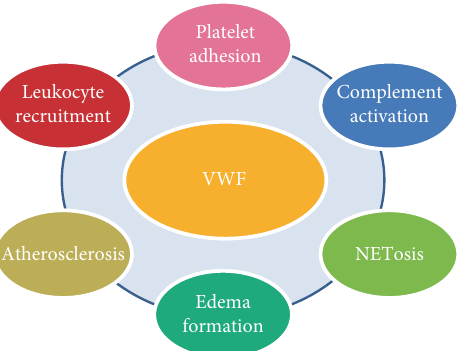
Figure 2: The “ solar system ” of VWF-mediated vascular in fl ammation. VWF is central in the “ solar system ” of vascular in fl ammation, and many in fl ammatory pathways orbit in its “ gravitational fi eld. ” VWF supports leukocyte and platelet recruitment in in fl amed tissue, modulates vascular permeability and edema formation, may promote atherosclerotic plaque formation and in fl ammation, and provides an activating surface for complement activation and NETosis. All these mechanisms may contribute to tissue injury and organ failure in thromboin fl ammatory disorders.